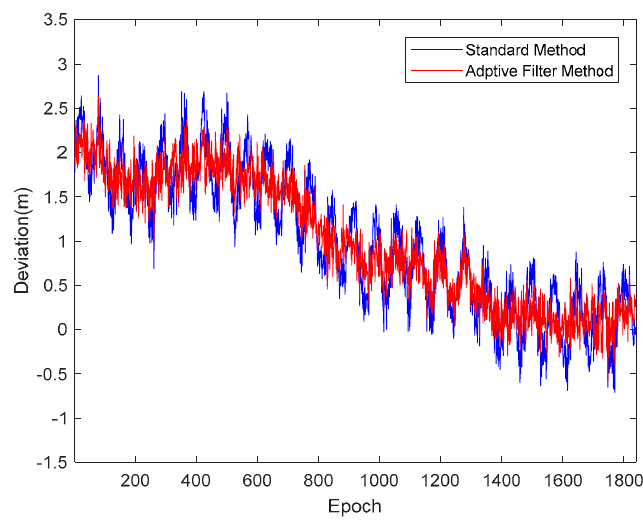
Figure 25. Pseudorange residuals comparison before and after frequency spectrum smoothing (G06, 1800 s).